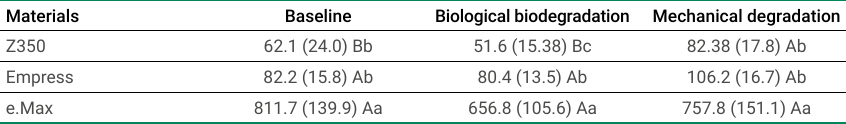
Table 3. Means (standard deviations) of the Knoop hardness (KHN) for the different experimental conditions. Materials